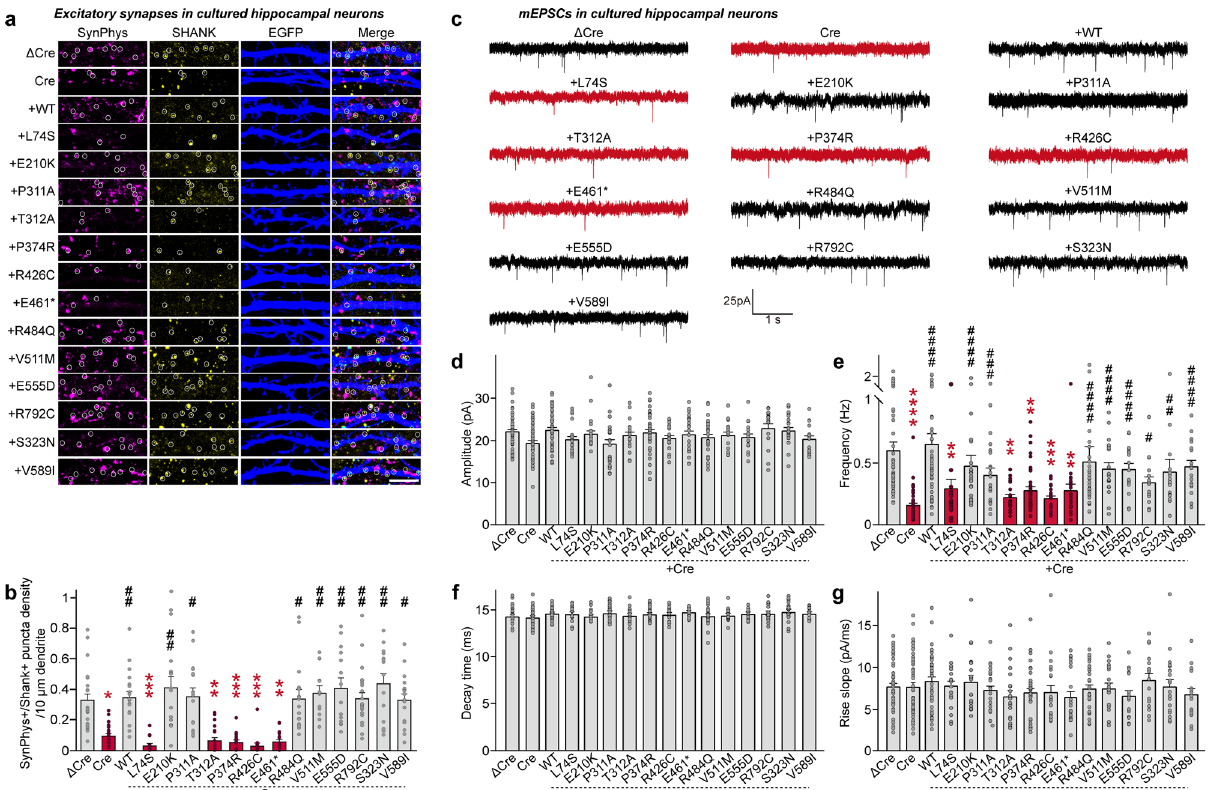
Fig. 6 Impaired rescue of excitatory synapse development and transmission in Slitrk2 -cKO hippocampal neurons by a subset of SLITRK2 variants. a Triple-immuno fl uorescence analysis of EGFP (blue), the presynaptic marker synaptophysin (SynPhys; magenta), and the excitatory postsynaptic marker SHANK (yellow) in mature cultured neurons (DIV14) derived from Slitrk2 f/f mice infected with lentiviruses expressing Δ Cre or Cre at DIV5. For rescue experiments, neurons infected with lentiviruses expressing Cre at DIV5 were transfected with vectors expressing WT or the indicated mutant forms of SLITRK2 together with EGFP vector at DIV8 – 9. Scale bar: 10 µ m (applies to all images). b Quanti fi cation of images in ( a ), showing the density of SynPhys + SHANK + puncta. All data are shown as means ± SEMs ( ‘ n ’ denotes the number of cells from fi ve independent experiments; Control vs. experimental group: Δ Cre, n = 22; Cre, n = 25; + WT, n = 18; + L74S, n = 12; + E210K, n = 17; + P311A, n = 16; + T312A, n = 18; + P374R, n = 16; + R426C, n = 13; + E461*, n